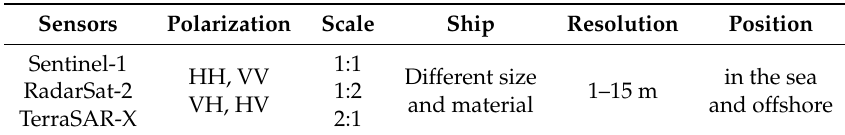
Table 2. The synthetic aperture radar (SAR) ship detection dataset (SSDD) contains different kinds of SAR ship image.